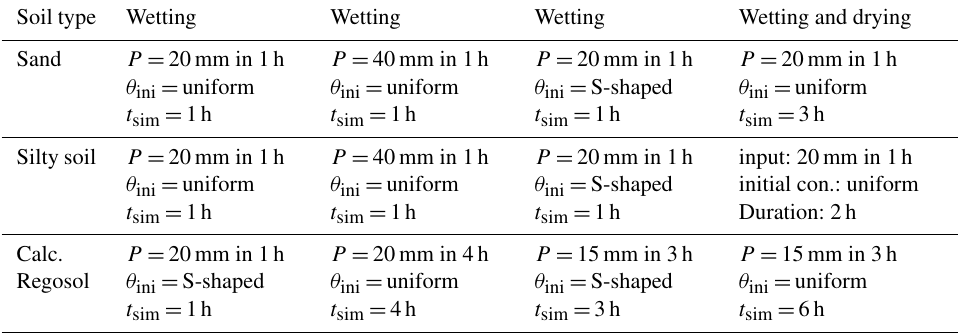
Table 1. Soil hydraulic parameters of the sandy soil on limestone, the young silty soil on schist and the Calcaric Regosol on loess: saturated hydraulic conductivity k s , saturated and residual water contents θ s and θ r , α parameter, and shape parameter n . Soil type